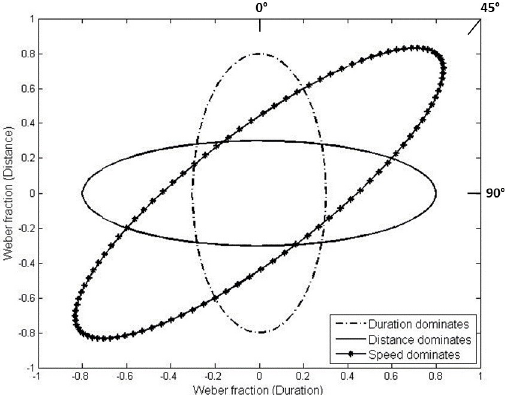
Fig 3. Exemplar ellipse’s orientations: Three exemplar ellipses have been applied to the distance-duration plane resembling the three dominant orientations: Duration-dominant orientation (0˚), speed-dominant orientation (45˚) and distance-dominant orientation (90˚). These ellipses’ orientations would suggest if participants are more sensitive towards temporal, speed or spatial cues of auditory motion.